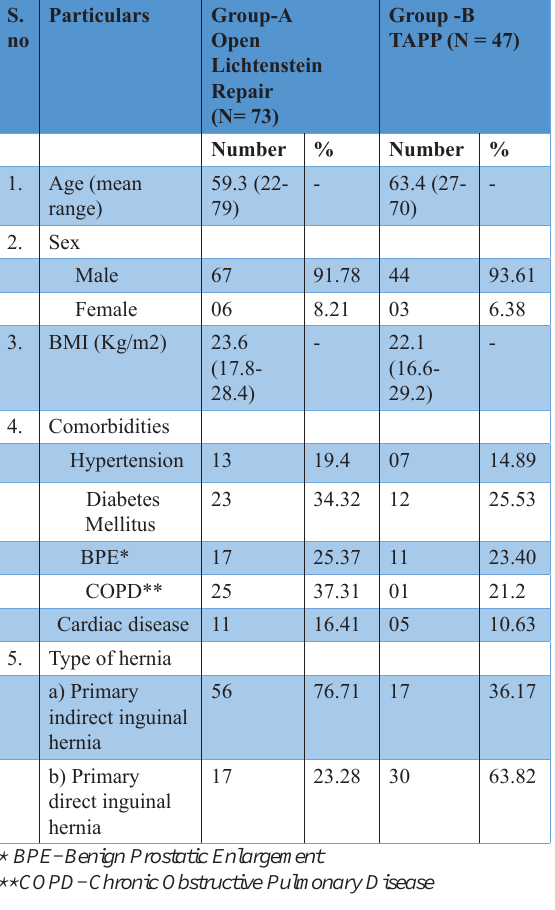
Table 2. Intraoperative complications during hernia 1. 2. 3.